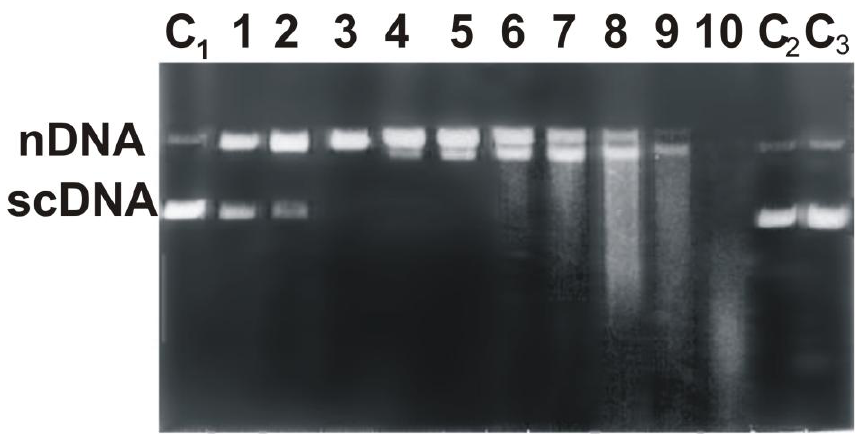
FIGURE 4. DNase activities of catalytic IgGs from patients with different ADs in the cleavage of supercoiled (sc) and nicked (n) plasmid DNA. Lanes 1–10, IgGs from the sera of 10 different patients; C 1 , scDNA incubated alone; C 2 and C 3 , scDNA incubated with Ab from the sera of two healthy